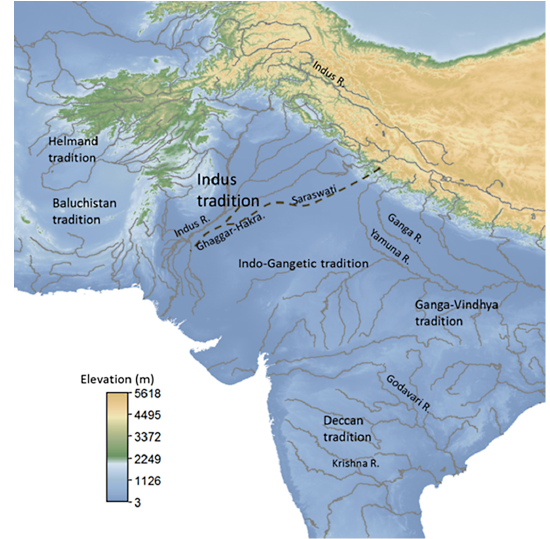
Fig. 4. The traditions of the Indian subcontinent between 5000 and 2000BP (after Kenoyer, 2011,